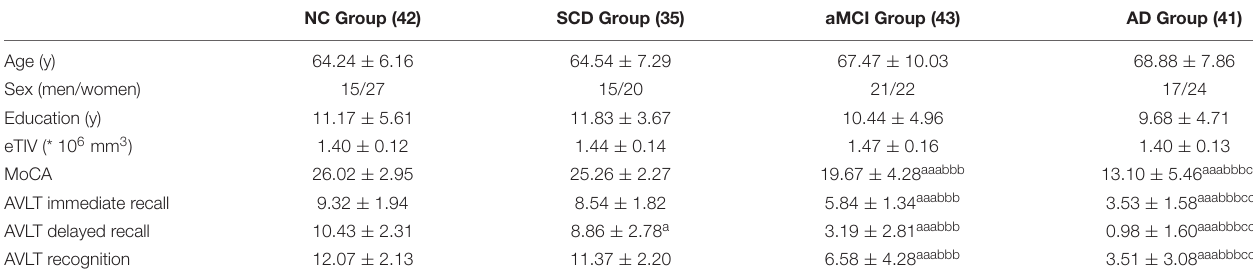
TABLE 1 | Demographic characteristics and neuropsychological